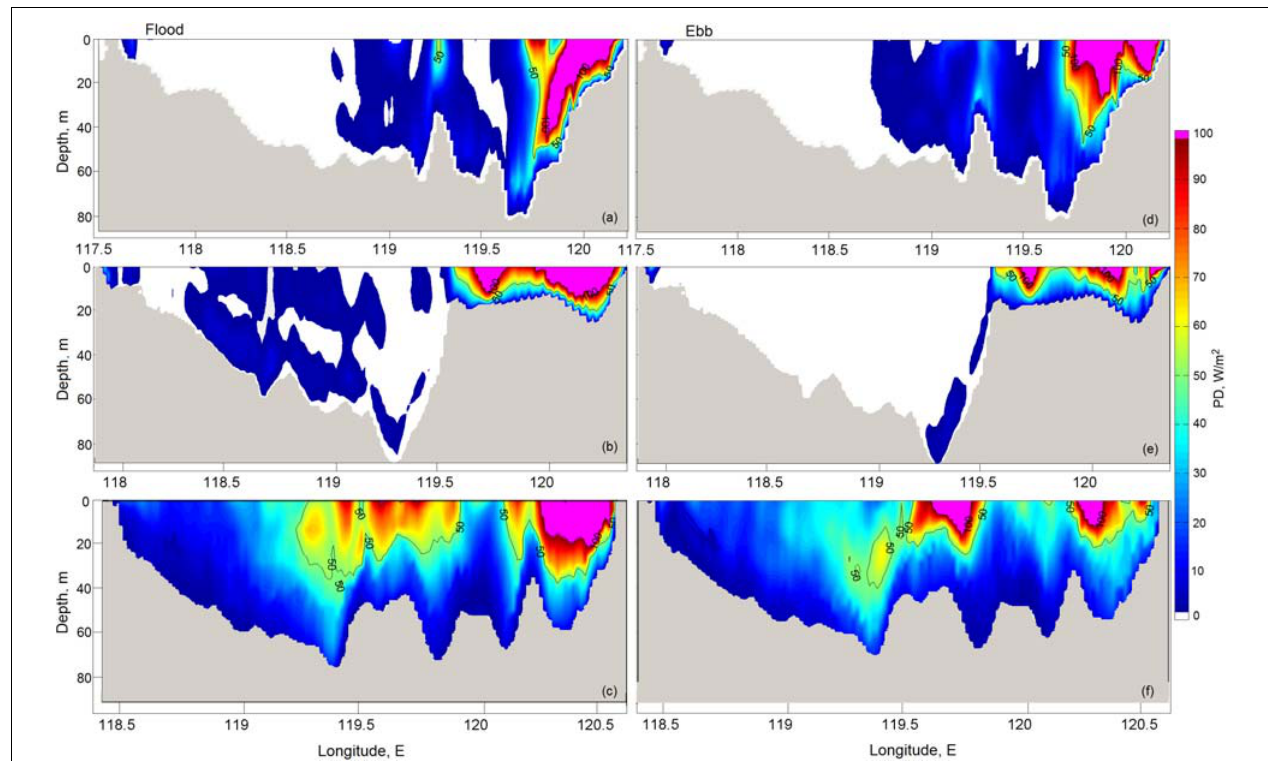
FIGURE 10 | The 20-min averaged power density along the zonal sections for peak flood (left panel) and ebb (right panel) velocities along (a,d) ZS1, (b,e) ZS2, and (c,f) ZS3, respectively.